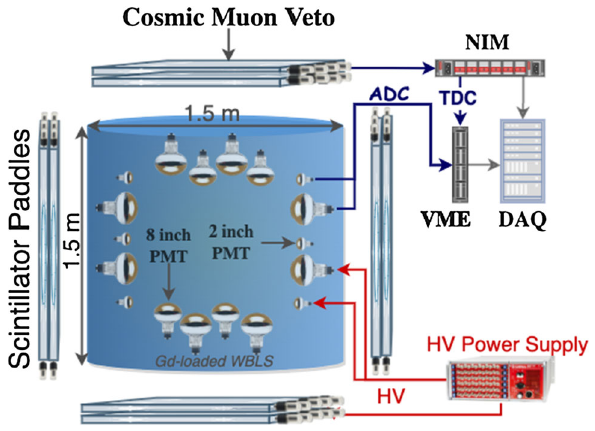
Fig. 4 Schematic view of the detector components, electronics and DAQ